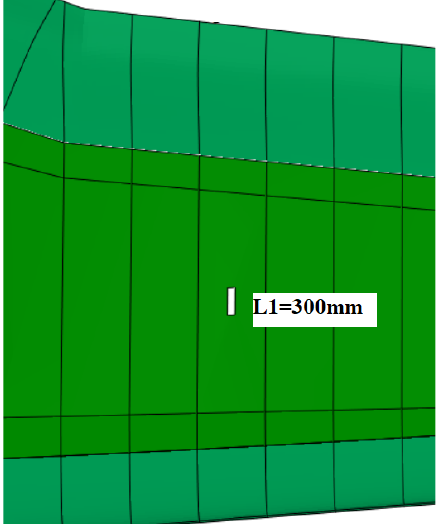
Figure 6. Illustration of the damage cutting through a single stringer component.